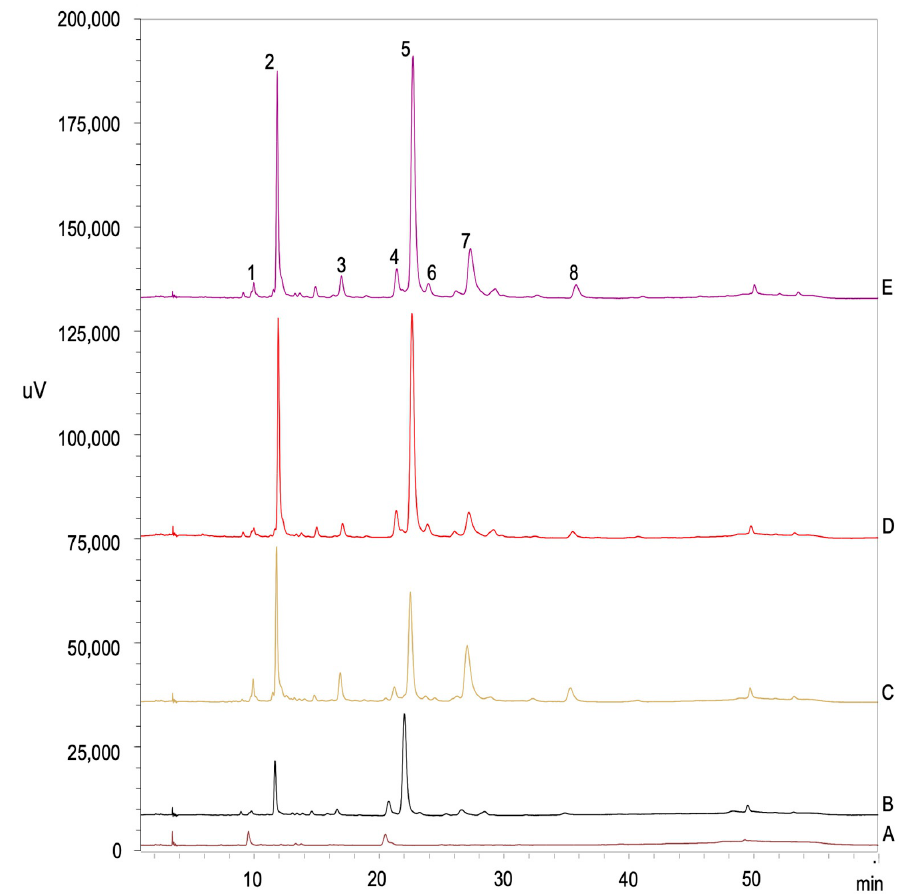
Figure 2. Ultra High Performance Liquid Cromatography (U-HPLC) chromatograms (shown at 320 nm) of identified phenolic compounds from methanol/water (80:20, v / v ) extracts of carrot seed ( A ) and carrot sprouts on 7 days in darkness+3 days of a light/darkness photoperiod under several light treatments at 20 °C: Darkness ( B ), Fluorescent ( C ), Blue+Red LEDs ( D ), and Blue+Red+Far-Red LEDs ( E ). Identified peaks are: Neochlorogenic Acid (1), Chlorogenic Acid (2), Caffeic Acid (3), p-coumaric Acid (4), Ferulic Acid (5), Hydroxycinnamic Acid (6), Rutin (7), and 1,2-disinapoyl-1’-ferulolylgentiobiose (8).